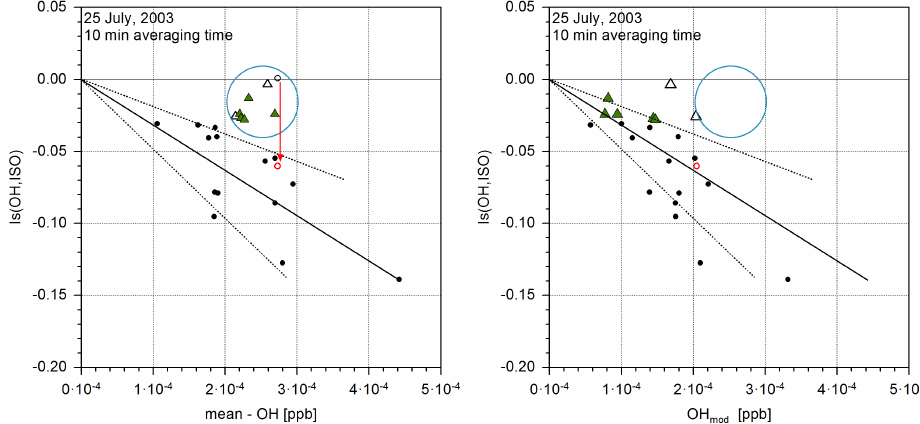
Figure 4. The intensity of segregation I S as a function of the measured mean OH mixing ratio with a relation proposed according to model calculations of Patton et al. (2001) (solid line). The sector between the dotted lines encloses a range of ± 40% around the solid line. Left part: data points outside this relation are within the blue circle. Right part: I S as a function of the modelled OH mod and OH – loss as given in Table 2 for mean mixing ratios of Table 1. The arrow gives the corrected value according to Sect. 5.3.4.